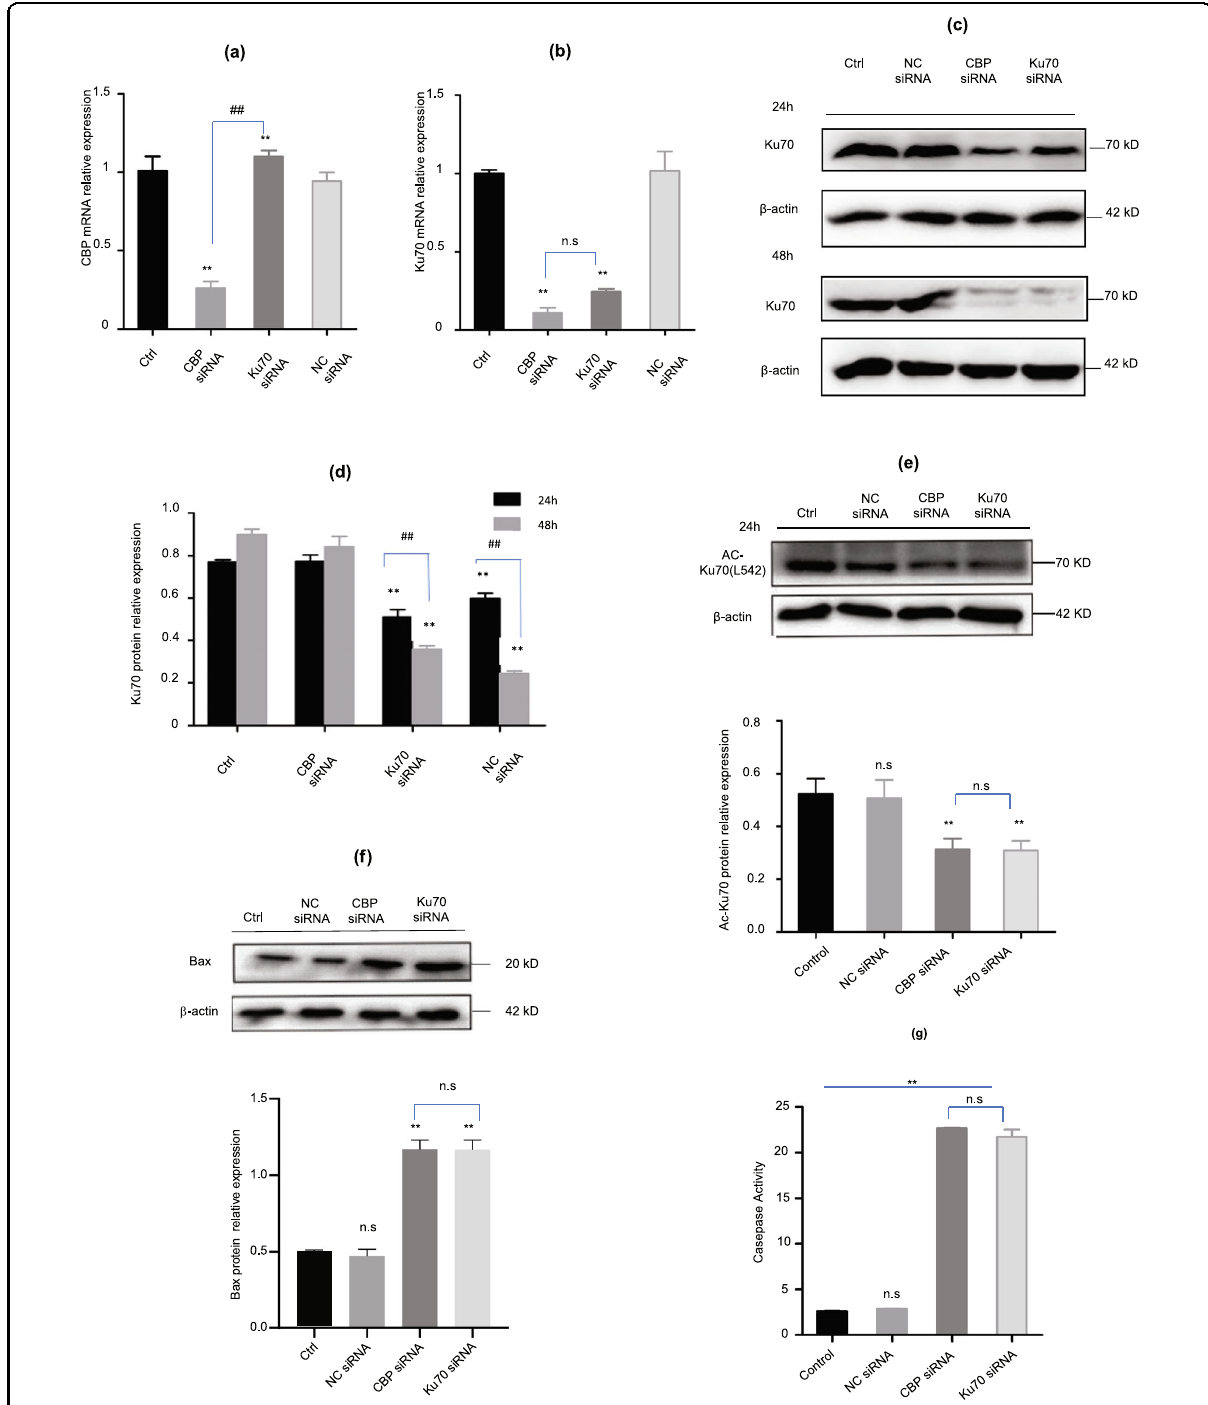
Fig. 6 Depletion of CBP downregulated the expression and acetylation modi fi cation of Ku70. a Changes in CBP mRNA in melanoma cells depleting either Ku70 or CBP, respectively; b changes in Ku70 mRNA in melanoma cells depleting either Ku70 or CBP, respectively; c changes in the level of Ku70 protein molecules in melanoma cells depleting either Ku70 or CBP for 24 and 48h, respectively; d quanti fi cations of Ku70 protein levels in melanoma cells when depleting either Ku70 or CBP based upon the western blotting in c ; e western blotting analysis on the Ku70(L542) (modi fi ed by acetylation at L542) in melanoma cells when depleting either Ku70 or CBP for 24h; f Western blotting analysis on the BAX in melanoma cells when depleting either Ku70 or CBP for 24h; g the elevated caspase-3 activity when depleting either CBP or Ku70. The caspase-3 activity was measured using the chromogenic substrate Ac- DEVD-pNA when the corresponding depletion was conducted for 24h. The bar represents the increase of the absorbance of pNA produced as a function of caspase-3 cleavages. Data as shown in the fi gures were expressed as mean±SEM ( n = 3). * P <0.05, ** P <0.01, # P <0.05, ## P <0.01, and n.s denotes P >0.05.